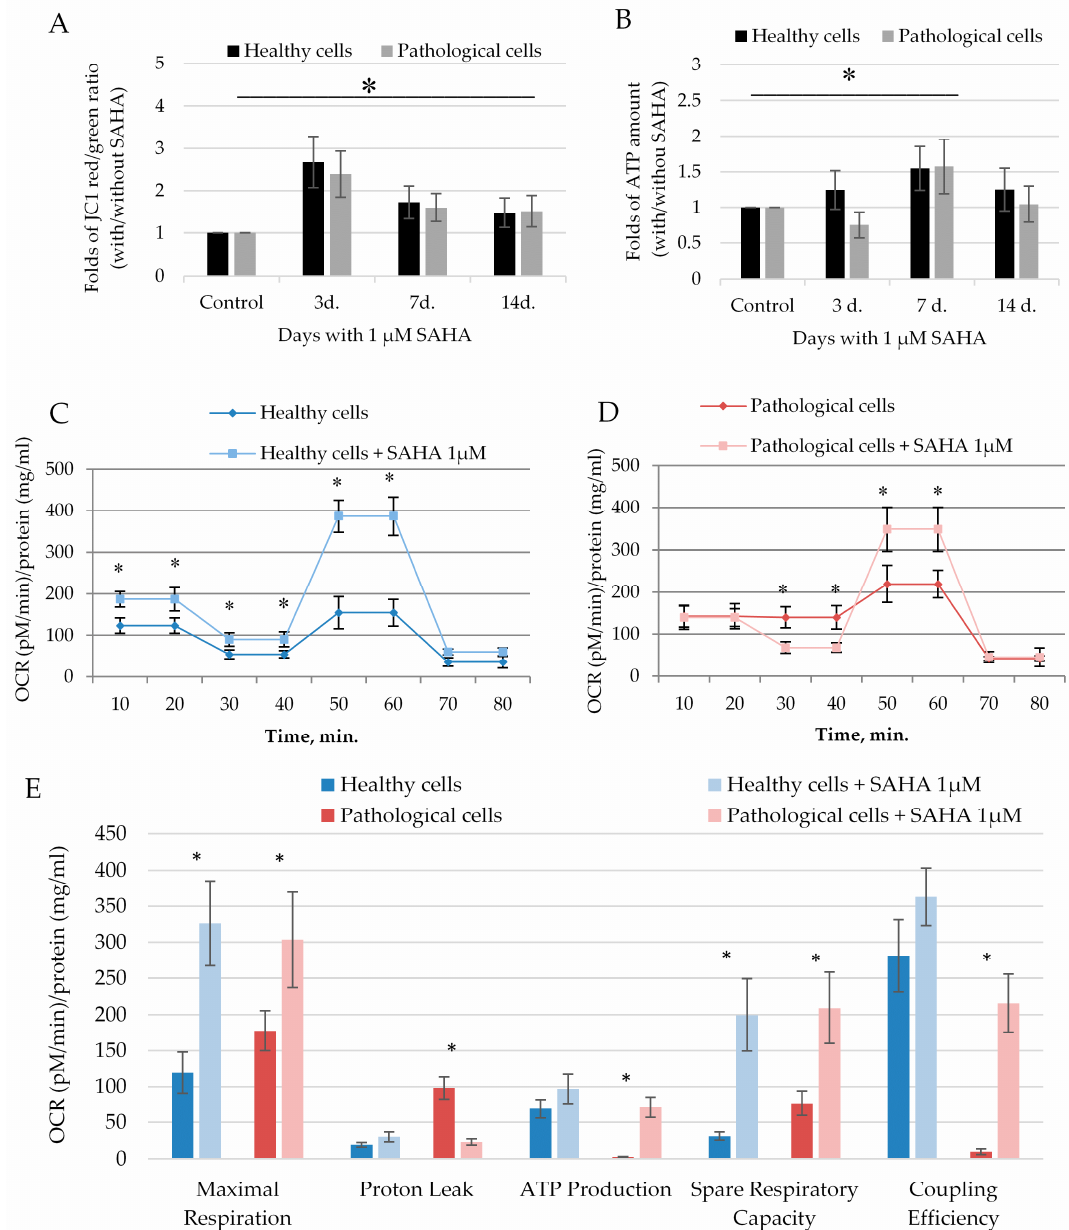
Figure 5. SAHA enhances the energetic status of healthy and pathological hmMSC. Mitochondrial membrane potential ( A ) and ATP production ( B ) in healthy and pathological hmMSCs exposed to 1 µ M of SAHA for three days. Changes of oxygen consumption rate (OCR) ((pM) / protein (mg / mL)) in healthy ( C ) and pathological ( D ) cells and calculated mitochondrial parameters ( E ) after exposure to SAHA. Data are displayed as fold of changes with and without SAHA. Control–cells of both types not a ff ected by SAHA. Data are shown as mean ± standard deviation (SD). The * p ≤ 0.05, n = 3 from 3 experiments. Student t -test was calculated by an Excel